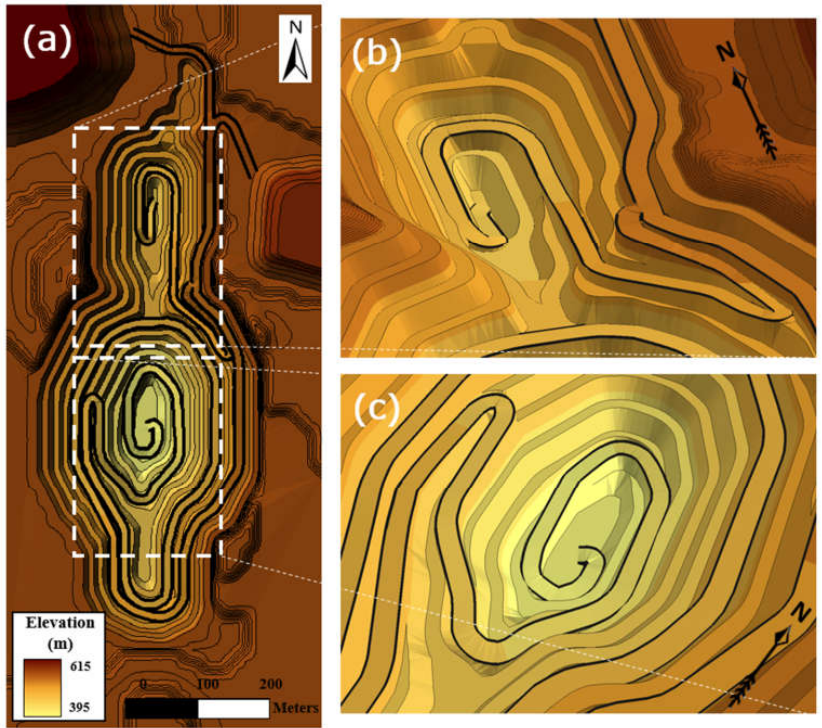
Figure 17. ( a ) Open‐pit mine with bench and haul road. 3D views: ( b ) Pit 2 area, ( c ) Pit 1 area.